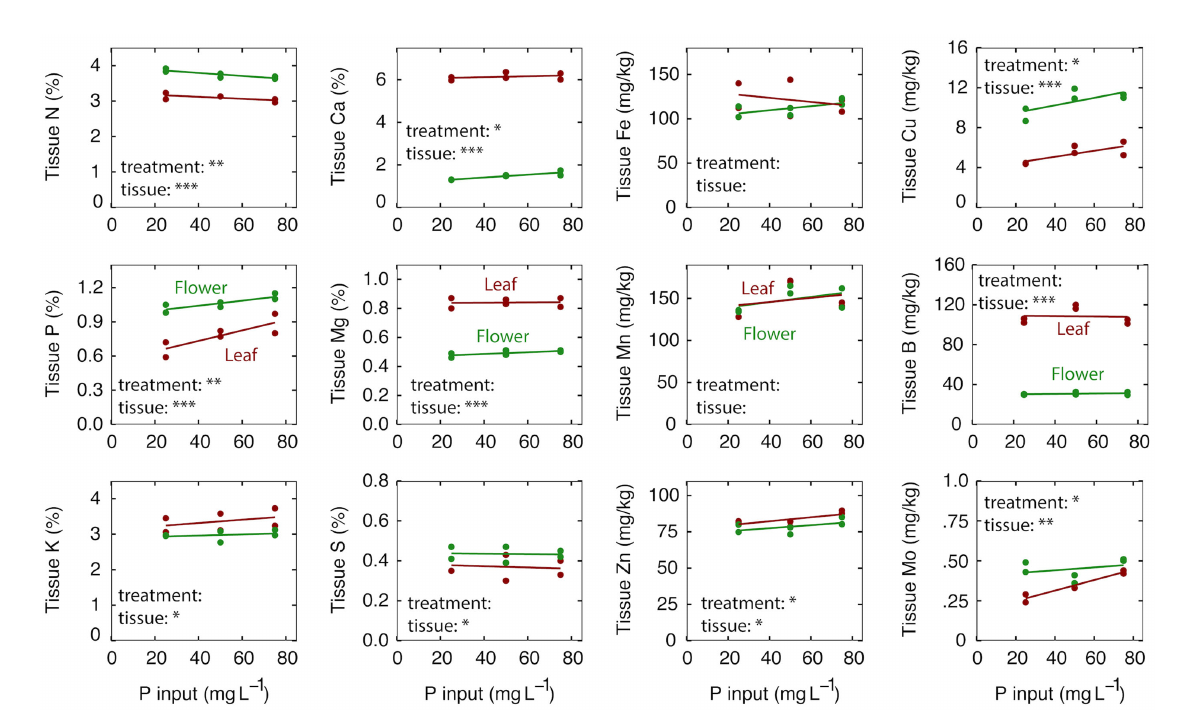
FIGURE 1 The effect of P input on tissue nutrient content at harvest after eight weeks of reproductive growth. Red lines represent leaf tissue; green lines represent fl ower tissue. Each point represents the average of plants in three separate containers that shared a common leachate collection tray. Signi fi cance codes for P treatment and tissue are as follows: *p < 0.05, **p < 0.01, ***p < 0.001. There was no interaction between P treatment and tissue for any element, so no signi fi cance codes are